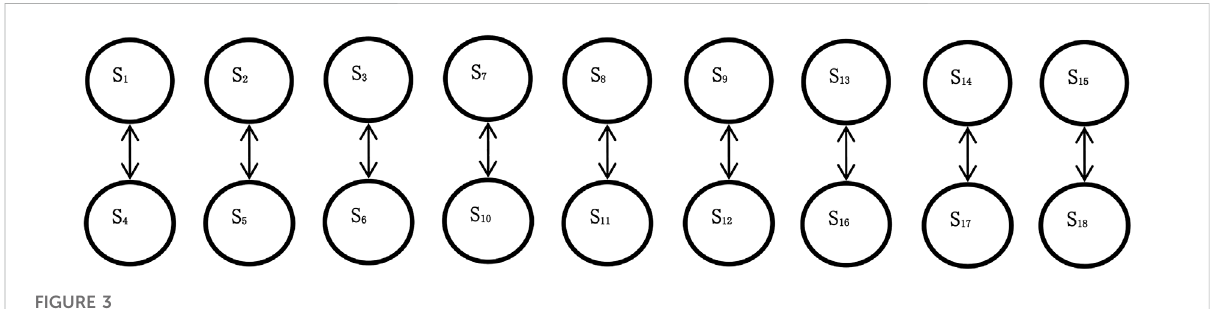
FIGURE 3 Local residents ’ state transition graph.